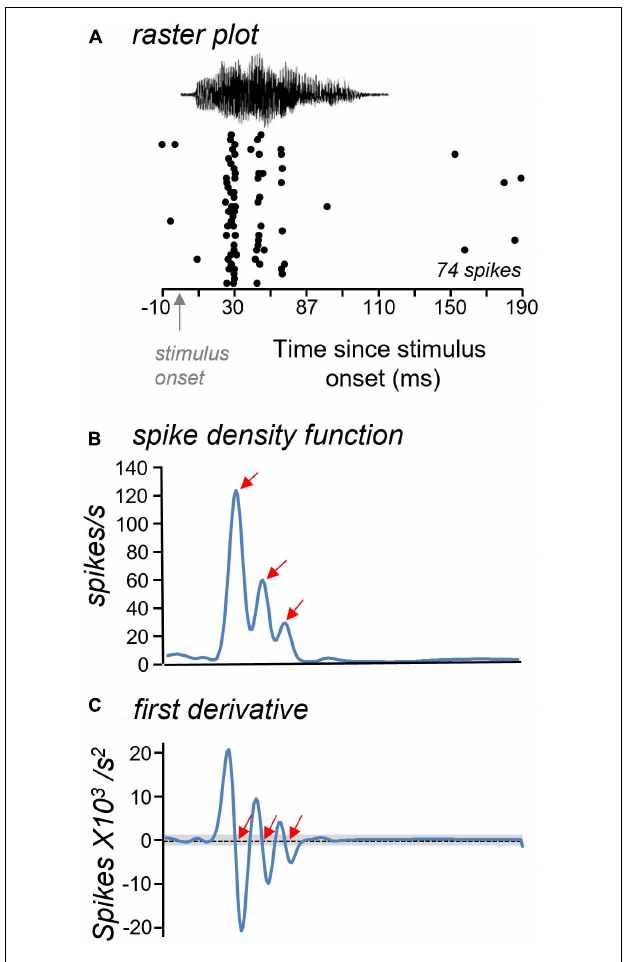
FIGURE 3 | Approach for measuring response features. (A) Raster plots were used to generate spike density functions. (B) Spike density function with three clear peaks (arrows) illustrating periods of high spike probability. (C) Response features were identified from the first derivative of the spike density functions as null crossings that were higher and lower than the threshold criterion (gray bar). Red arrows mark identified response features. The time axis is the same in all